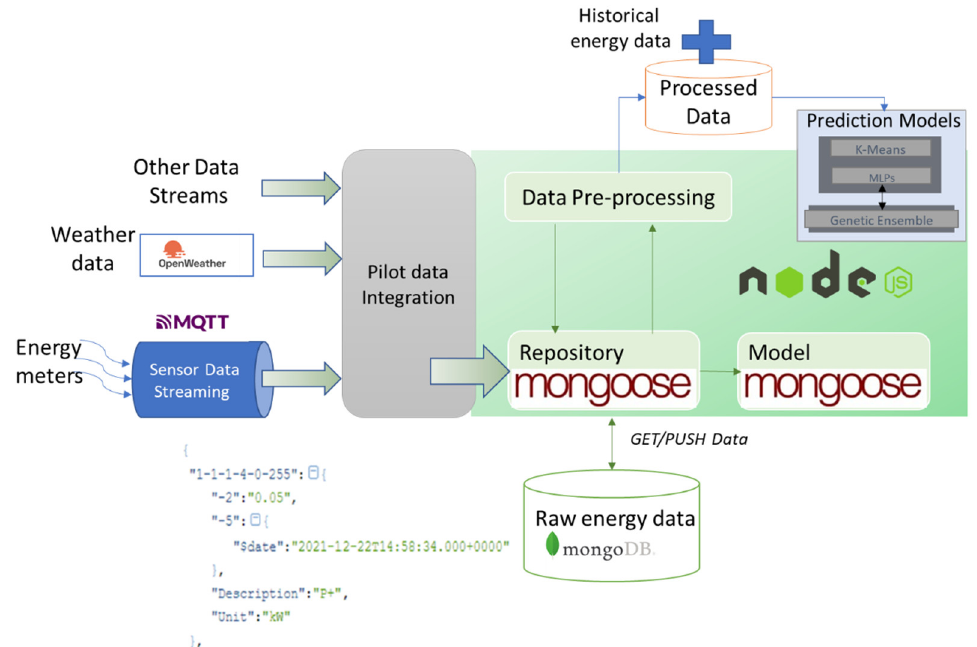
Figure 6. Proof-of-concept prototype used in evaluation.